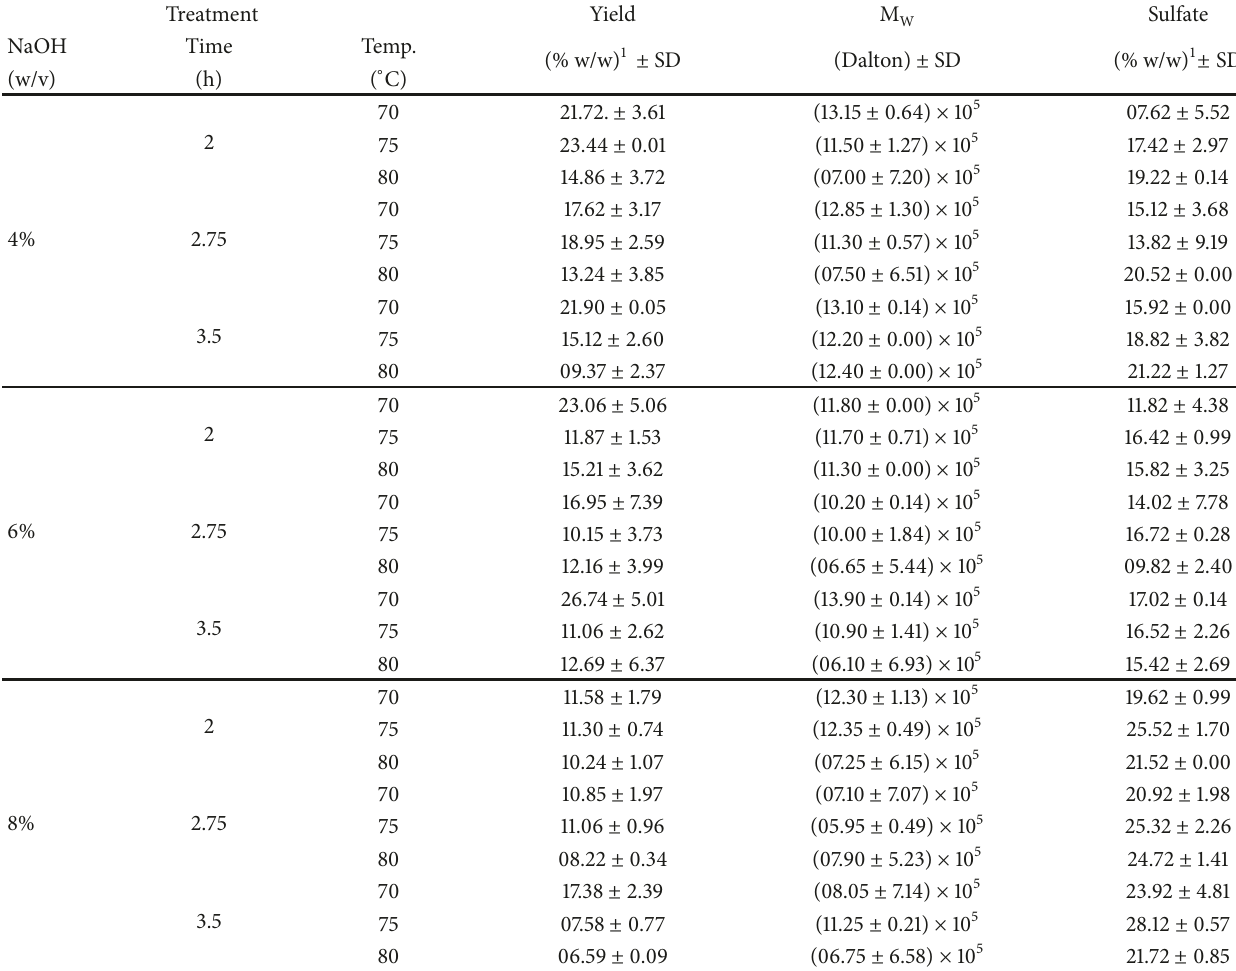
Table 1: Properties of Carrageenan extracted from Hypnea bryoides under different alkali pre-treatment conditions. Treatment Yield M W Sulfate NaOH Time Temp.